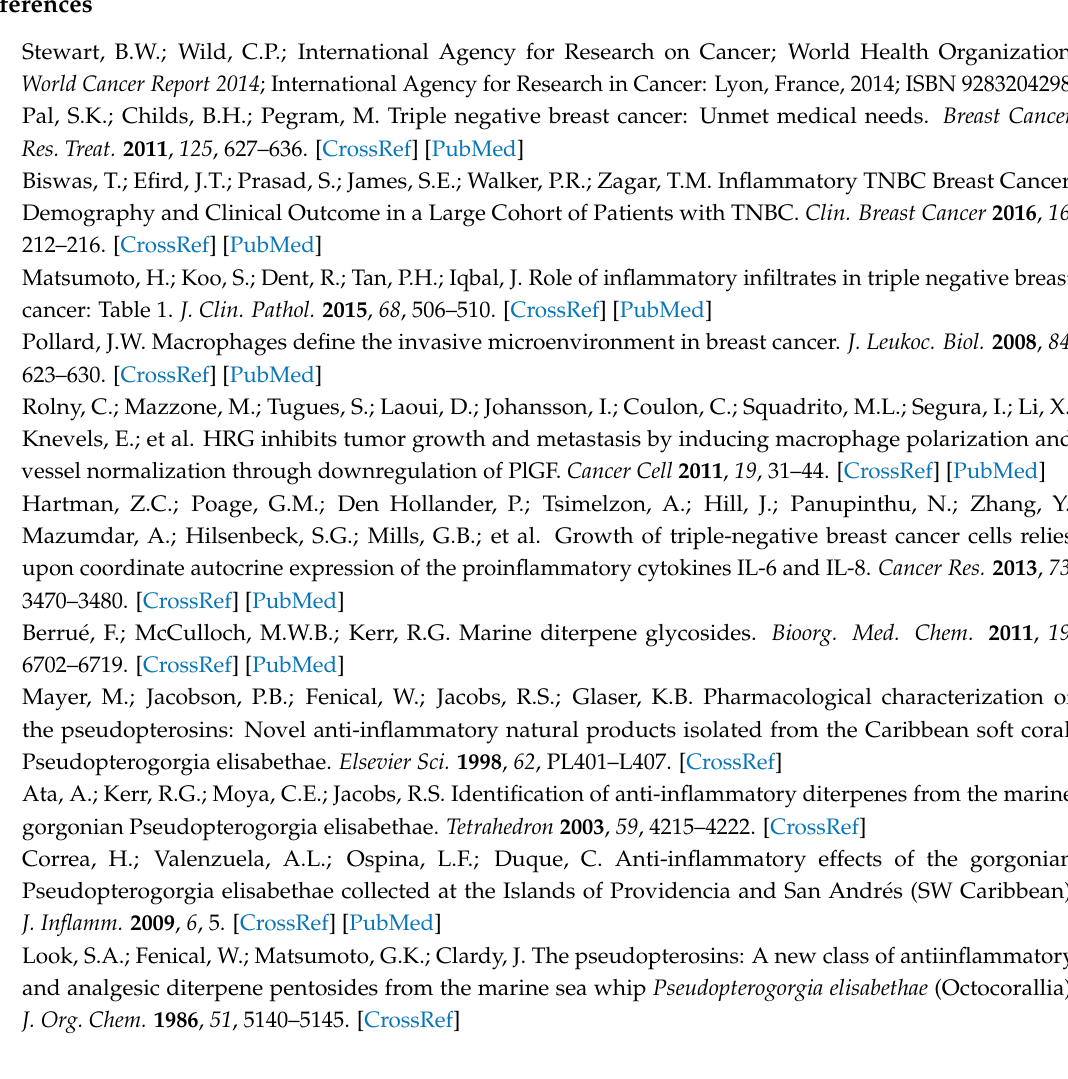
treatment. Figure S3: Pseudopterosin did not change ERK phosphorylation status in MDA-MB-231 cells. Figure S4: Pseudopterosin failed to inhibit breast cancer cell proliferation after knockdown of the GR α after 72 h. Figure S5: Pseudopterosin does not inhibit spheroid growth. Figure S6: Pseudopterosin inhibited bidirectional communication between TNBC cells and